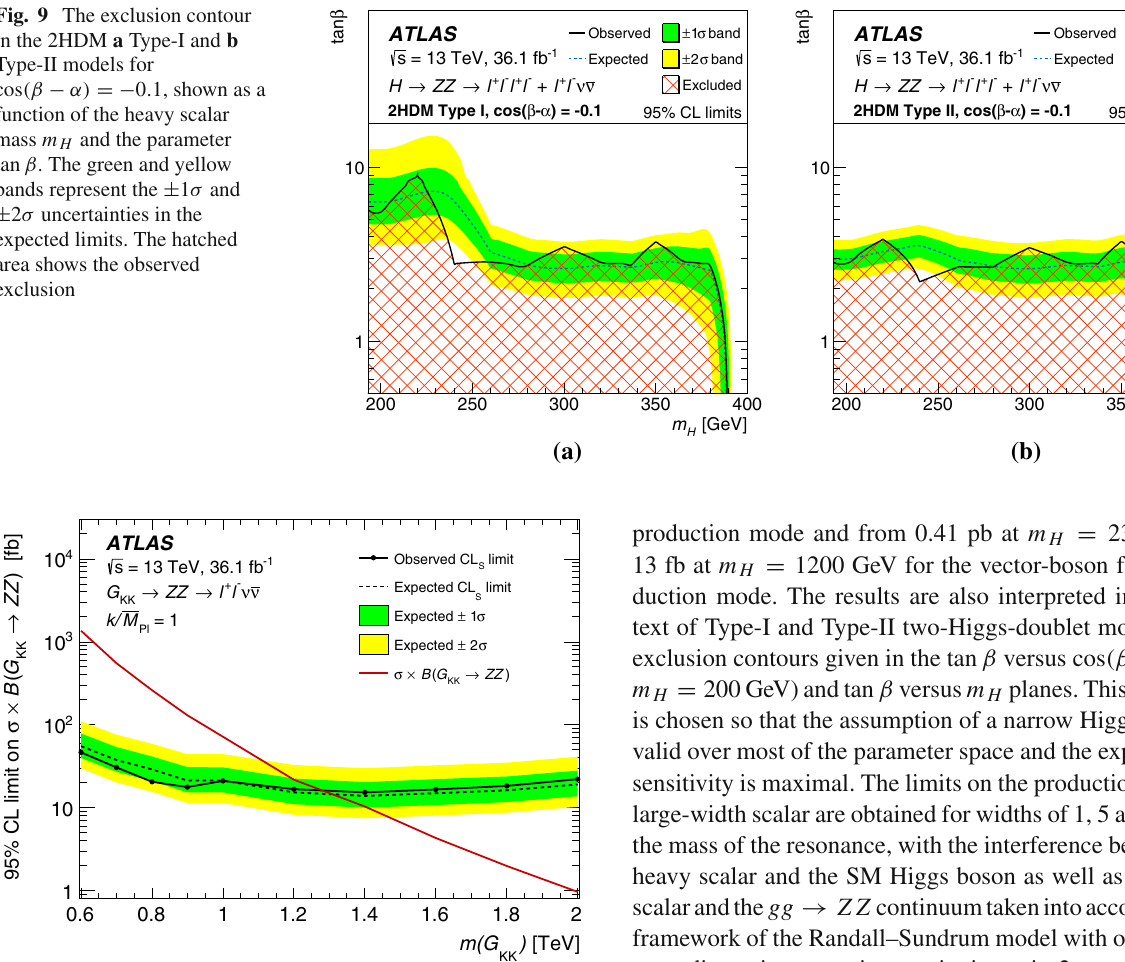
Fig. 10 The upper limits at 95% CL on cross section times branching ratio σ × B ( G KK → Z Z ) for a KK graviton produced with k / ¯ M Pl = 1. The green and yellow bands give the ± 1 σ and ± 2 σ uncertainties in the expectedlimits.Thepredictedproductioncrosssectiontimesbranching ratio as a function of the G KK mass m ( G KK ) is shown by the red solid